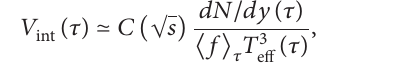
/𝑑𝜂⟩ = 9.2 . The data are taken from ch